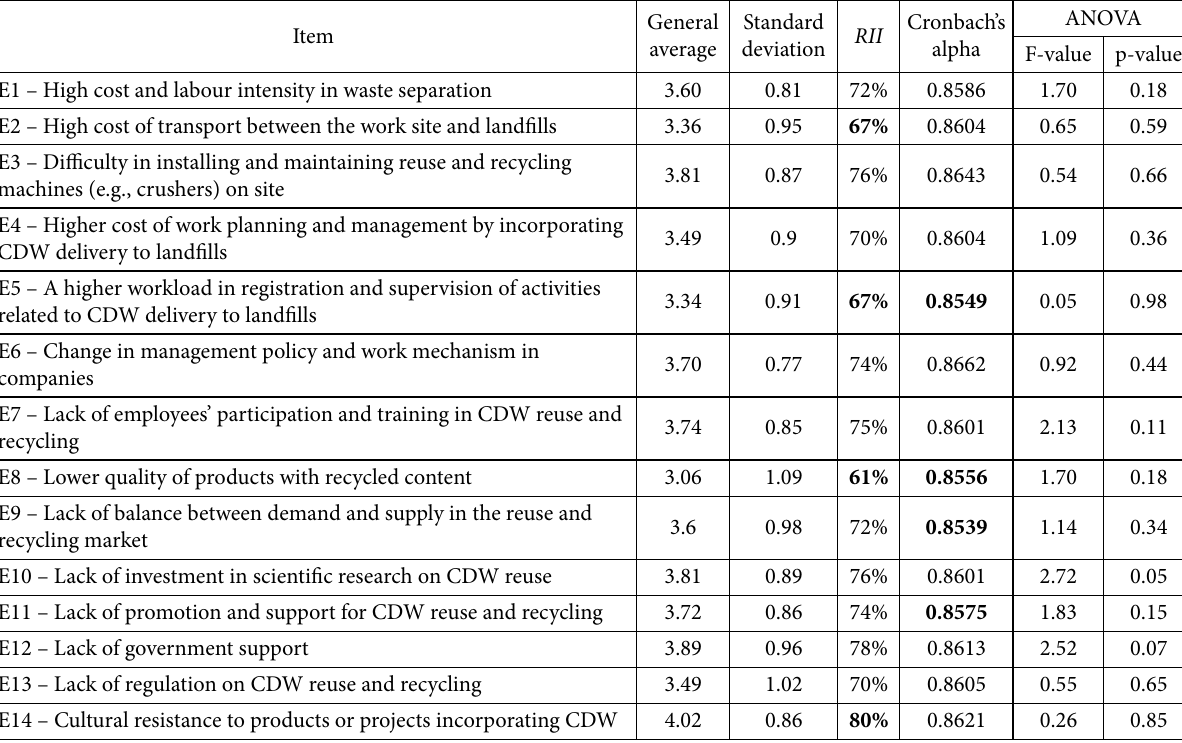
Table 9. Analysis of the general survey sample data regarding the factors hindering CDW reuse and recycling (Cronbach’s alpha =